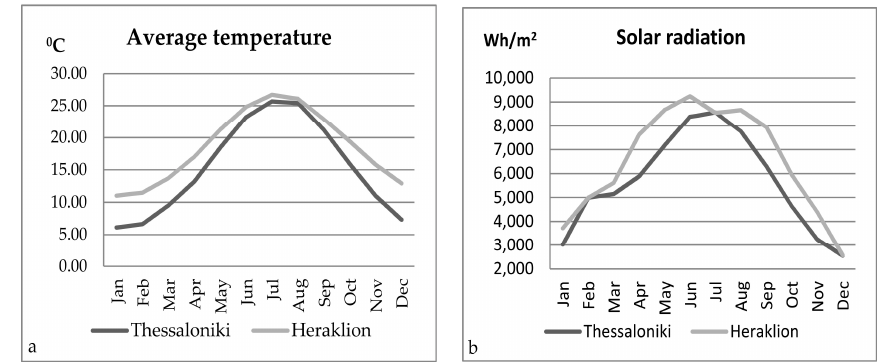
Figure 2. Maps of the two cities examined. ( a ) Thessaloniki built up area; ( b ) Heraklion built up area [35].